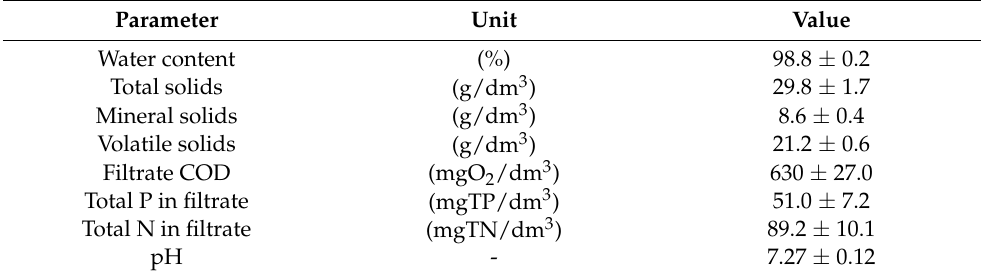
Table 2. Characteristics of the anaerobic sludge inoculum used in the